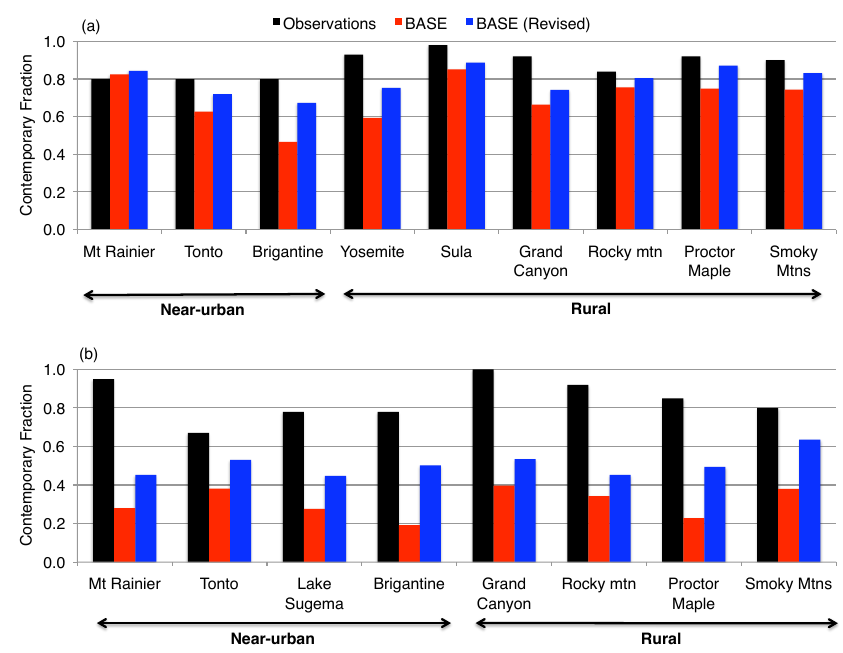
Fig. 10 : Contemporary fraction of OA at IMPROVE sites during the (a) summer and (b) winter months compared with model results from BASE and BASE (Revised). Data are from Schichtel et al. (2008).